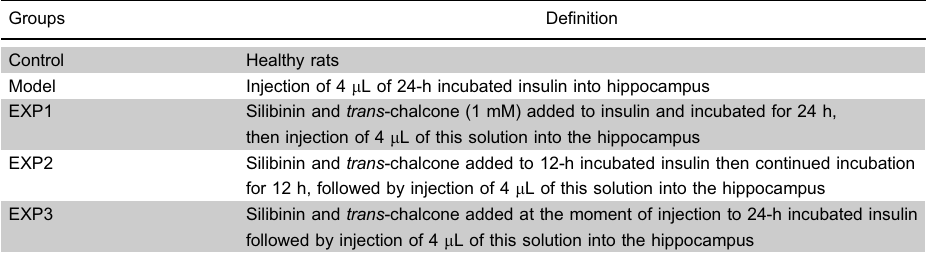
Table 1. Description of the experimental groups with Wistar